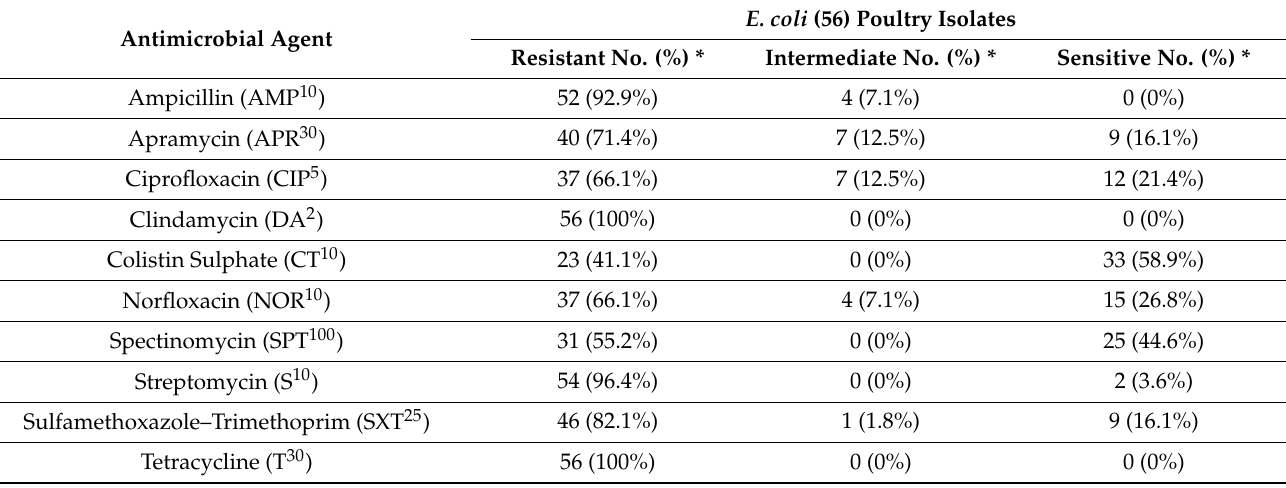
Table 2. Antimicrobial sensitivity patterns of isolated E. coli from poultry.